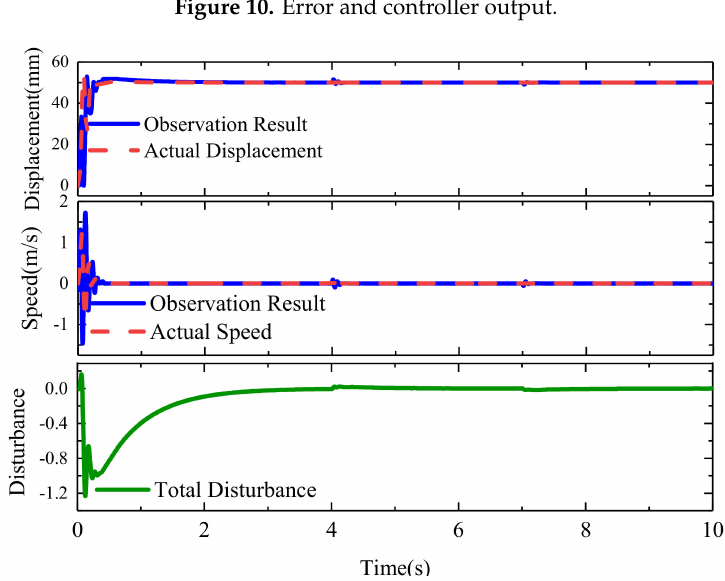
Figure 10. Error and controller output.